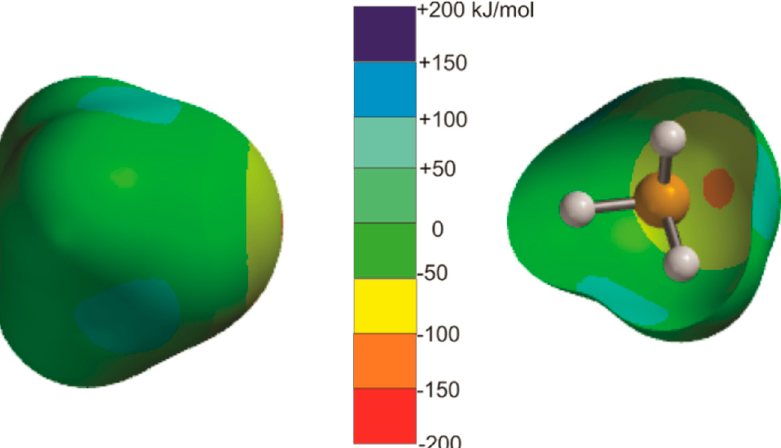
Figure 4. Molecular electrostatic surface potentials (MESPs) for phosphine calculated for the 0.002 e/bohr 3 iso-surface at the MP2/6-311++G** level. The surface in the right-hand diagram is cut away to reveal both the electrophilic (blue) regions near P on approximately the extension of the H–P bonds, and the nucleophilic (red dot) region on the C 3 axis.